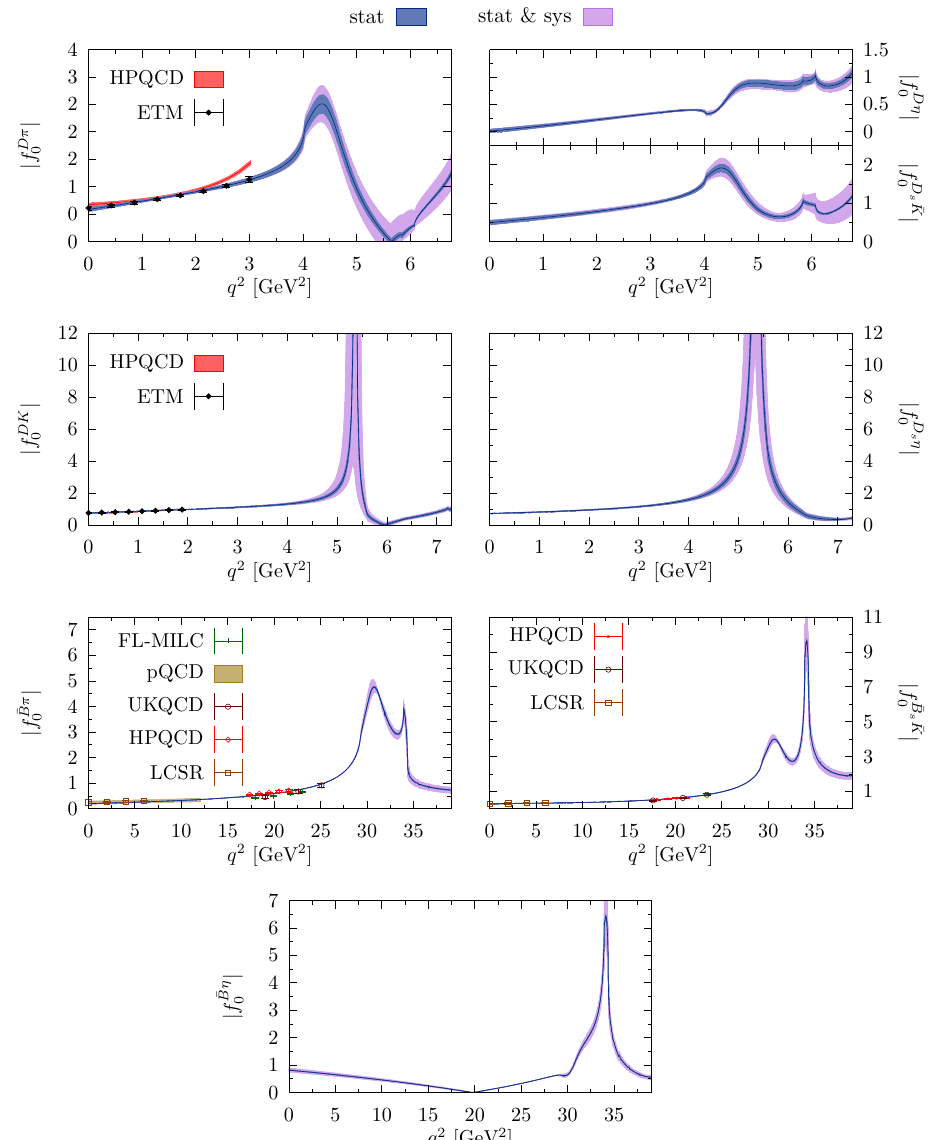
Fig. 11 Scalar form factors for different b → u and c → d , s tran- and LCSR results below q 2 max . Statistical (stat) and statistical plus sys- tematic (stat & sys) 68%-confident level bands are also given and are calculated as explained in Fig.